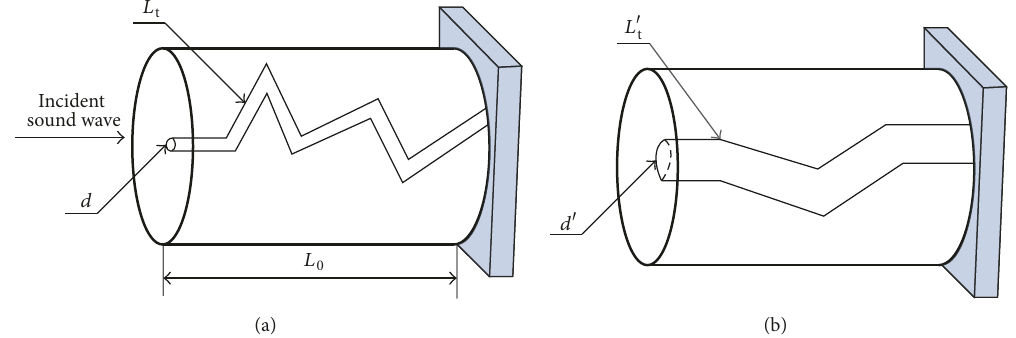
Figure 2: Schematic of sound propagation pathways of the PFMM. (a) The d -sized capillaries; (b) the illustration of the decrease in tortuosity with increasing capillary diameter.